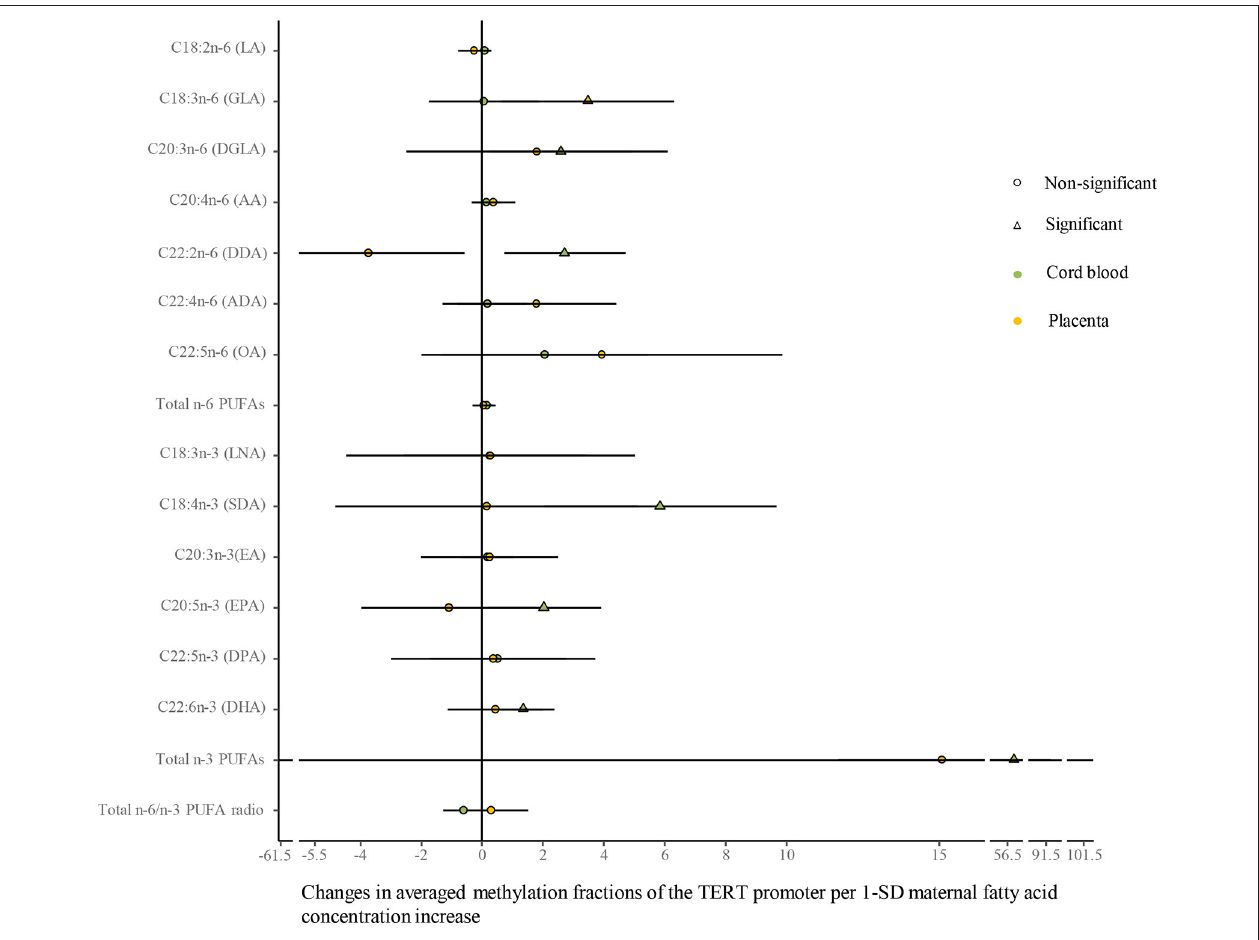
FIGURE 6 | Differences in the associations of maternal fatty acids and average methylation fractions of CpG sites in the TERT promoter between the cord blood and the placenta. The continuous model is used to include the SD score as maternal fatty acid concentrations, where maternal fatty acid concentrations are independent variables and average methylation fractions of CpG sites in the TERT promoter are dependent variables. β -coefficients and 95% CI are adjusted for gestational age at birth, infant sex, birth weight and length, and maternal age, maternal prepregnancy BMI, and gestational weight gain, and paternal age and BMI, and represent the changes in average methylation fractions of CpG sites in the TERT promoter in the cord blood and the placenta with a 1-SD increase in maternal fatty acids. Circle: non-significant; triangle: significant; color green: the cord blood; color yellow: the